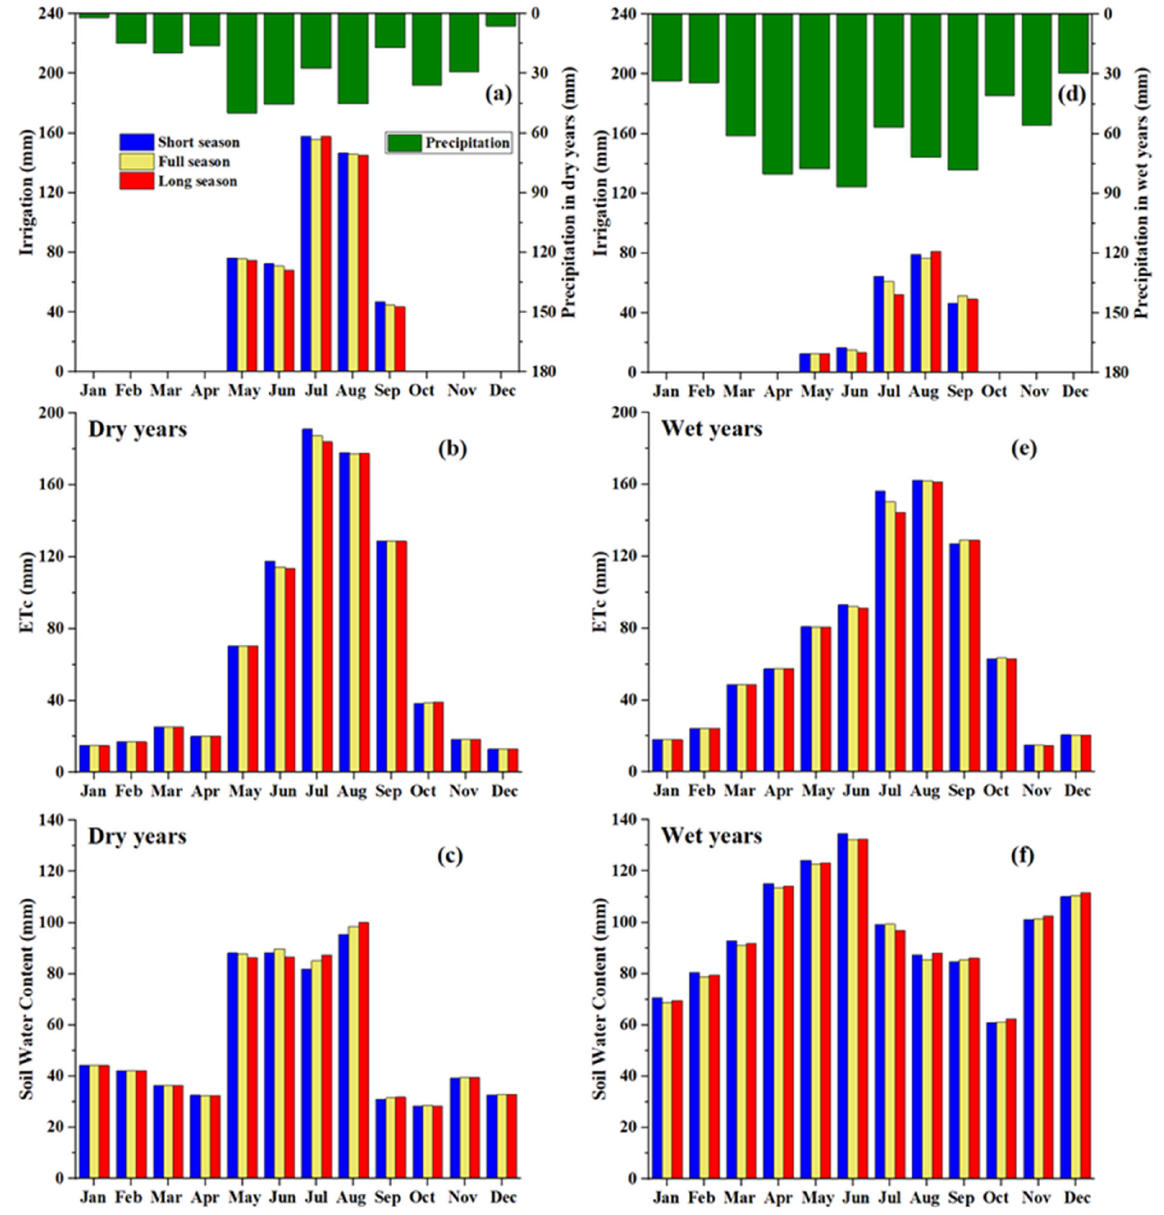
Figure 6. Comparison of average monthly irrigation ( a , d ), crop evapotranspiration (ET c ) ( b , e ), and soil water content ( c , f ) during dry and wet years using different maturity cultivars in the irrigated cotton HRUs in the Double Mountain Fork Brazos basin.